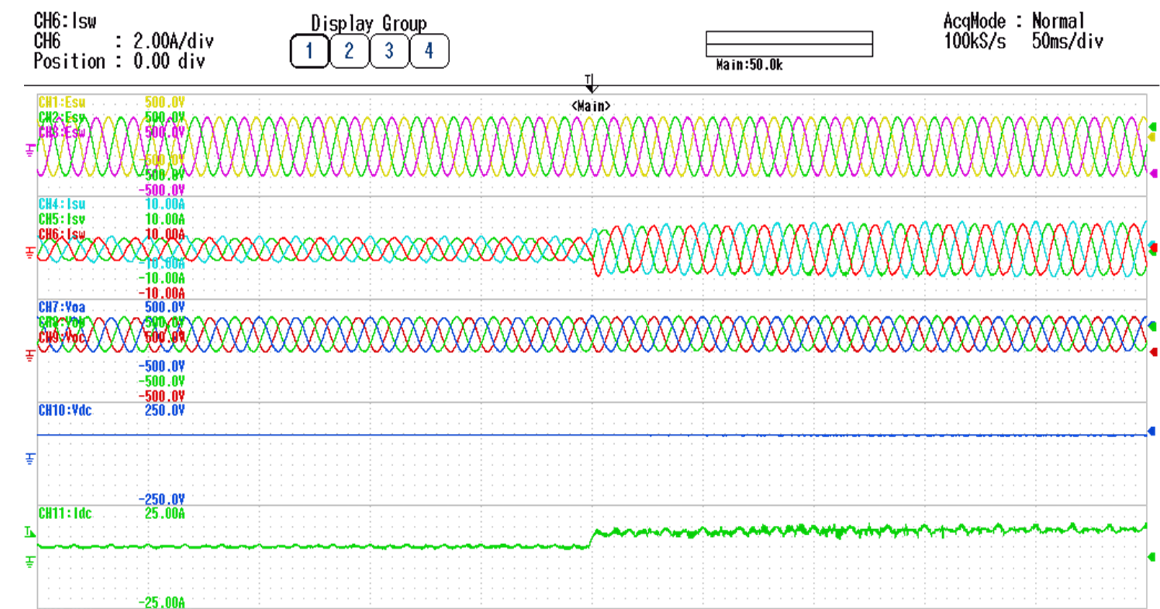
Figure 12. Experimental results of the IFBI during step-changed grid-injected power from 0.5 kW to 1.6 kW.